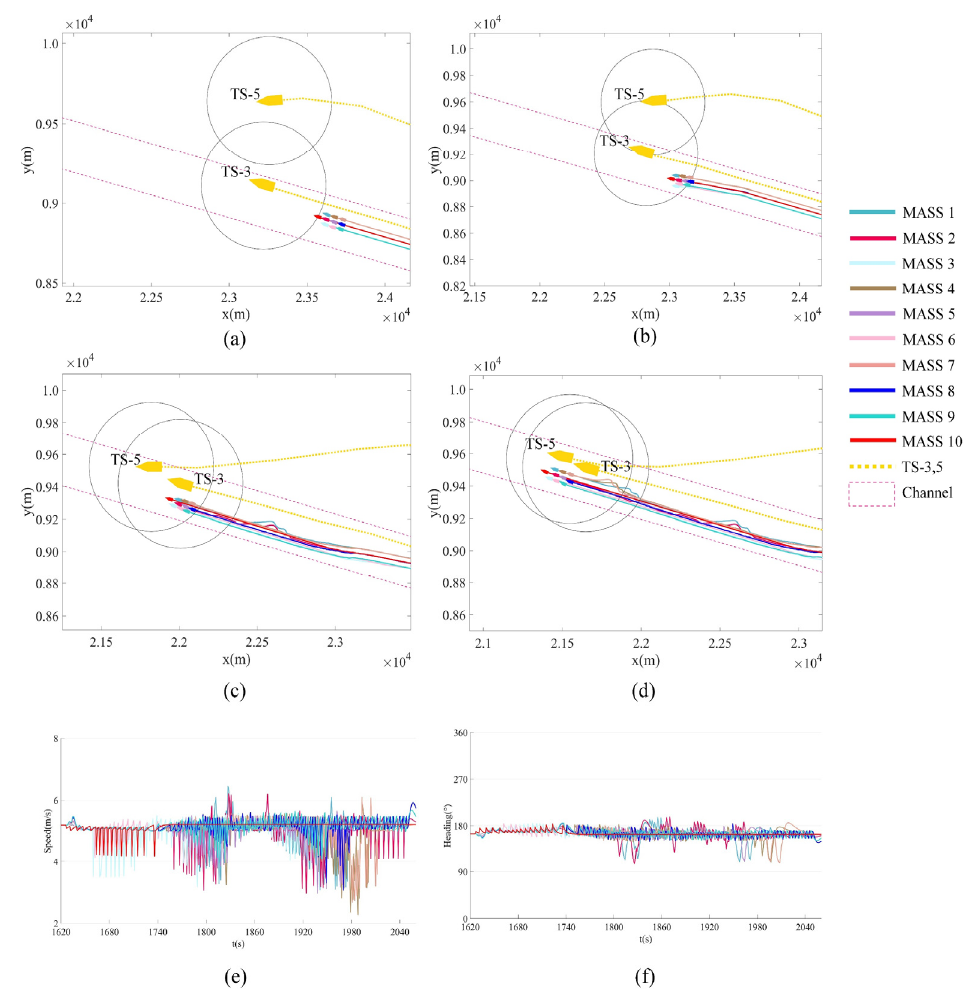
Figure 17. MASS formation encountered two target ship situations. ( a ) About to form an encounter situation with TS-3. ( b ) Gave priority to TS-3 avoidance. ( c ) Avoidance completion of encounter situation with TS-3 and encountered TS-5. ( d ) Avoidance completion of encounter situations to adjust formation pattern. ( e ) MASS speed changes during the situation. ( f ) MASS heading changes during the situation.